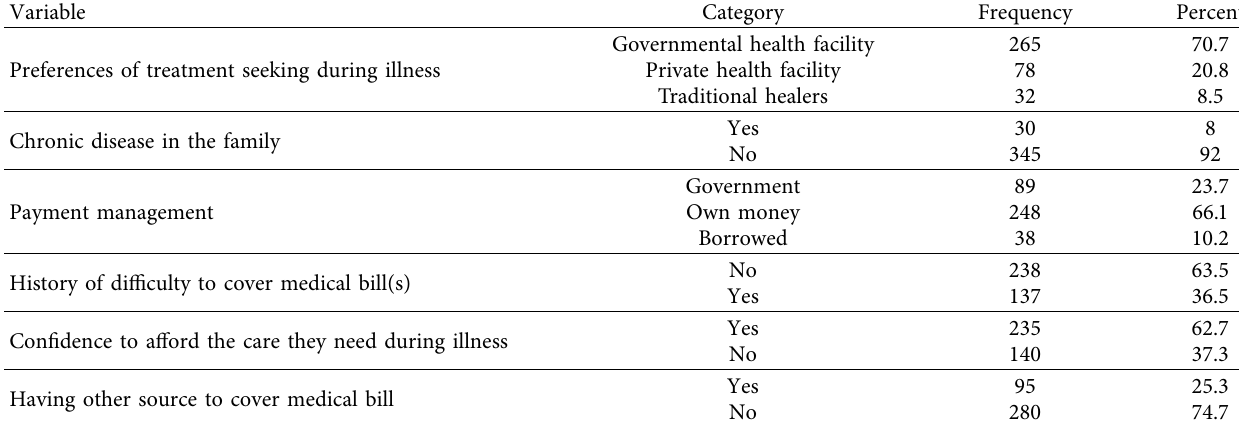
Table 2: Health status and healthcare utilization of the government employees in Muja town, northeast Ethiopia, 2016 ( n � 375).